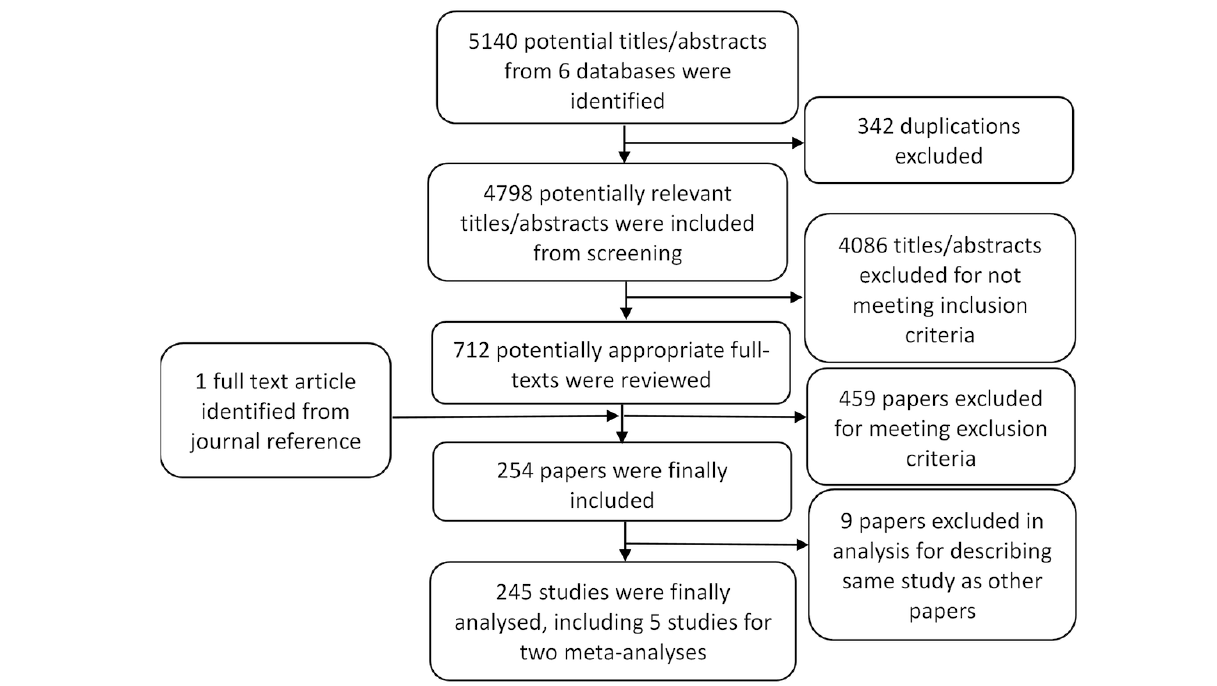
Figure 1. Identification process for eligible studies.